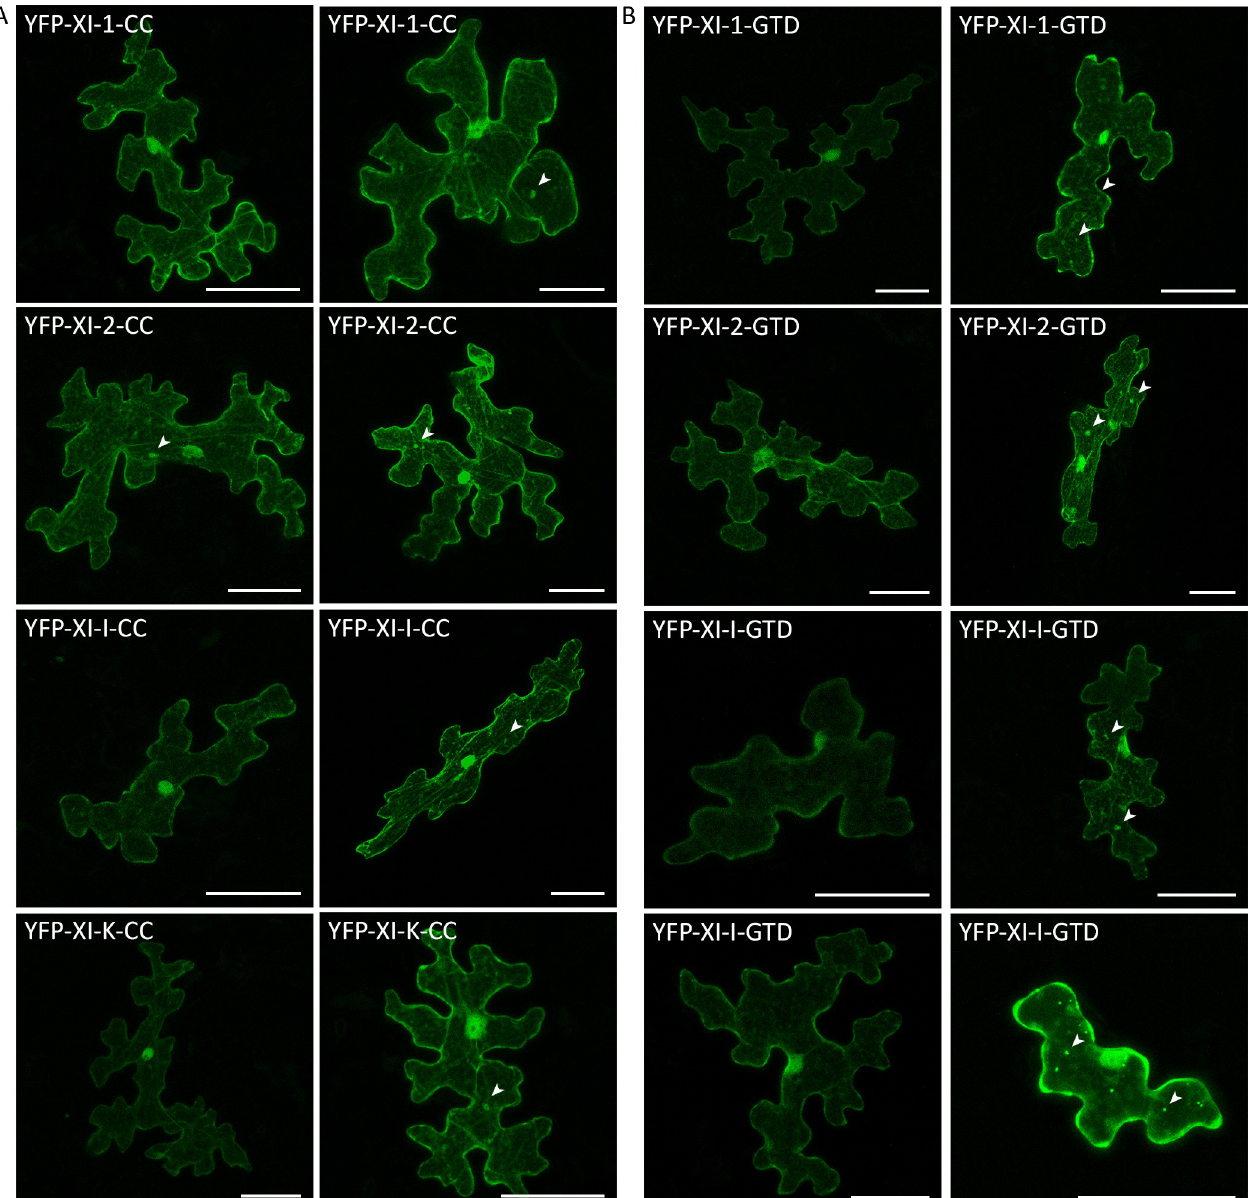
Fig 3. Localization of myosin fragments in Arabidopsis epidermal cells. Transient expression of (A) myosin coiled-coils and (B) myosin GTDs in Col-0 epidermal pavement cells. The first columns display representative cells showing mainly cytoplasmic localization, the second columns display representative cells showing dot-like structures and small aggregates, indicated by arrow heads. The scales display 50 μ m.